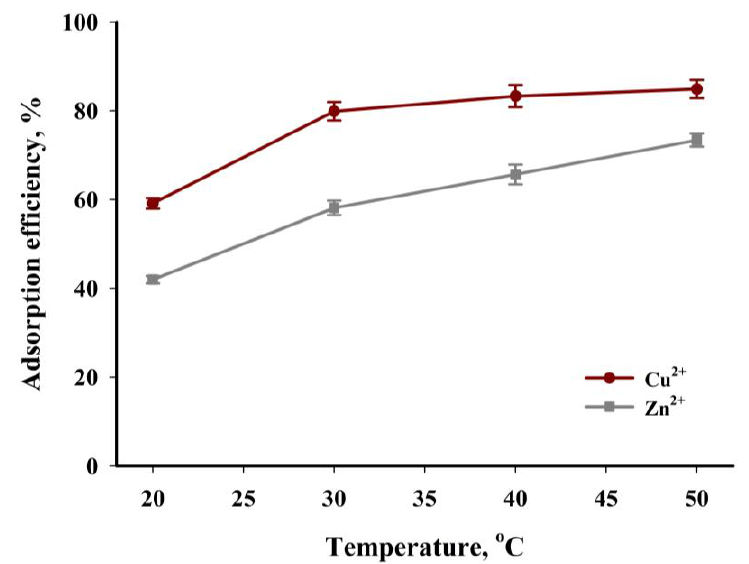
Figure 14. The influence of the studied process temperature on the adsorption efficiency ( t = 240 min, c = 200 mg·dm −3 , mass of adsorbent = 6.67 g·dm −3 , pH = 5). c = 200 mg · dm − 3 , mass of adsorbent = 6.67 g · dm − 3 , pH =